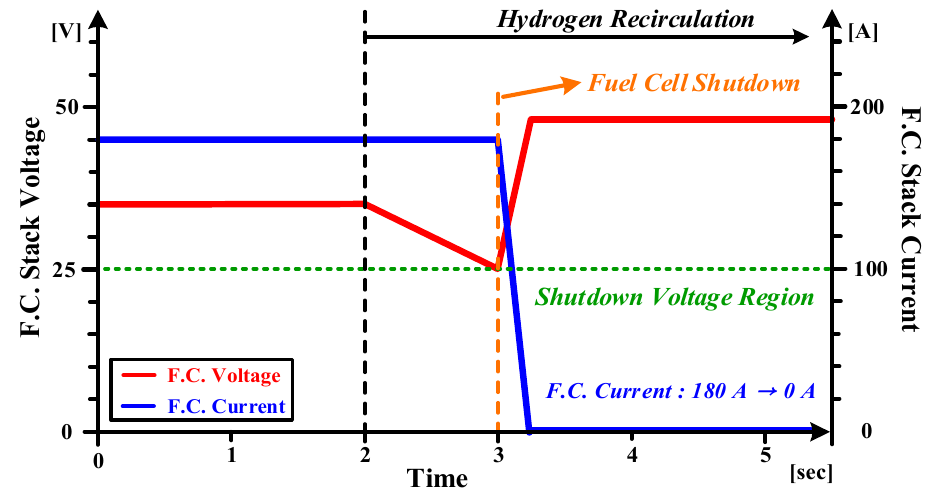
Figure 3. Fuel cell stack waveforms for conventional control method during hydrogen recirculation.